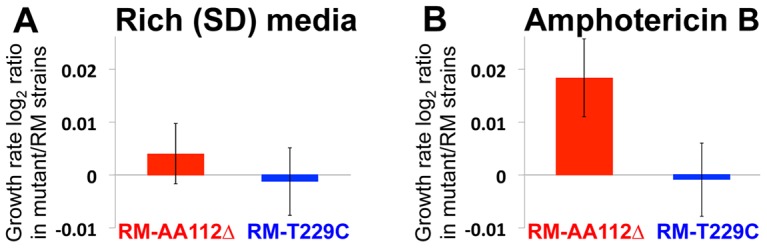
Fitness effect of the causal mutation.(A) In rich synthetic defined (SD) media, the RM AA112Δ strain and RM T229C strains show no significant difference from RM. (B) In the presence of the antifungal drug amphotericin B, the RM AA112Δ strain shows a growth rate advantage over RM, whereas the RM T229C strain shows no difference from RM. Bars represent the mean log2 ratios of log-phase growth rates from 48 replicate cultures, +/−1 S.E.